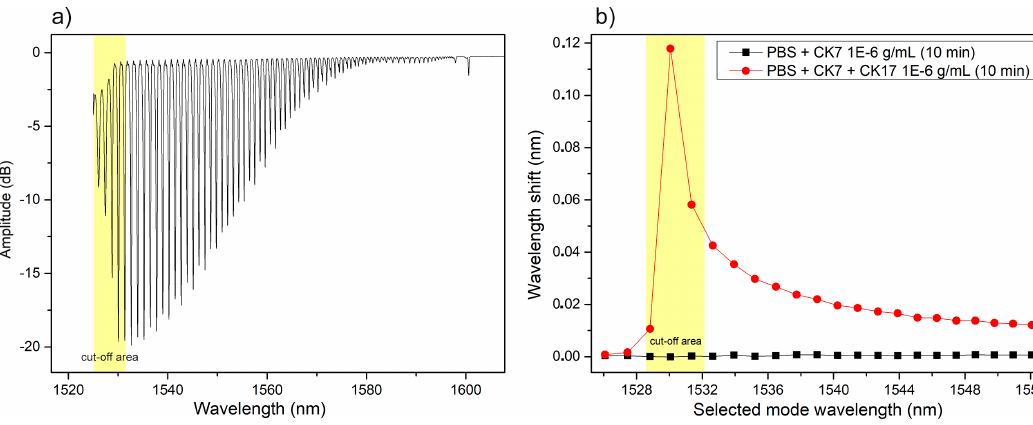
Figure 4. Cut-off area of Bare-TFBG spectrum. ( a ) The wavelength shifts do clearly indicate an increase in response towards the cut-off mode (near 1529 nm in this case) and also a total lack of response of the device exposed to a large concentration of the wrong target protein (CK7) referred as our negative control ( b ).